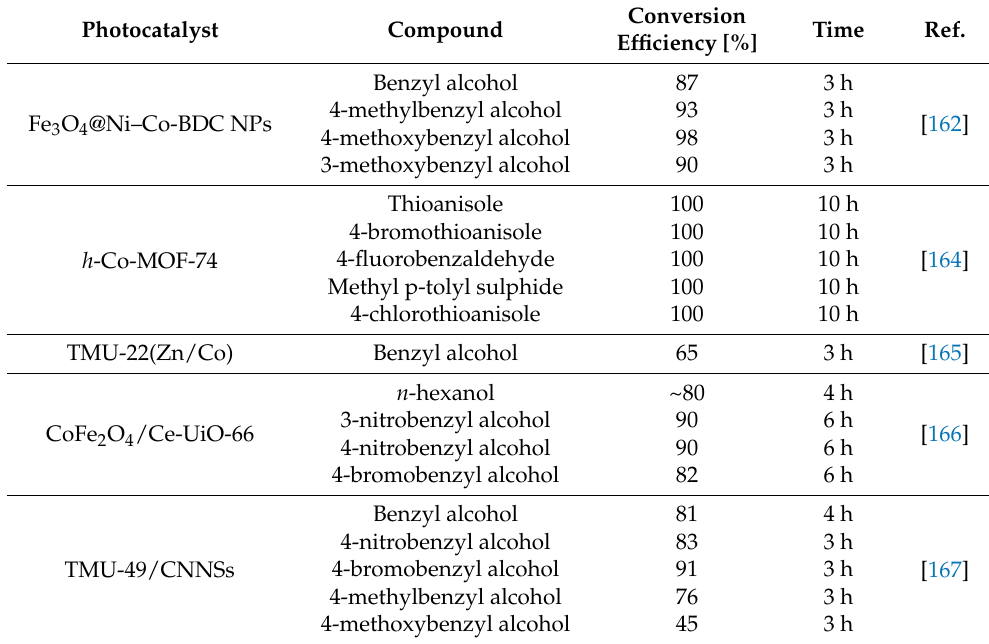
Examples of Co-based MOFs used in the photocatalytic oxidation of various organic